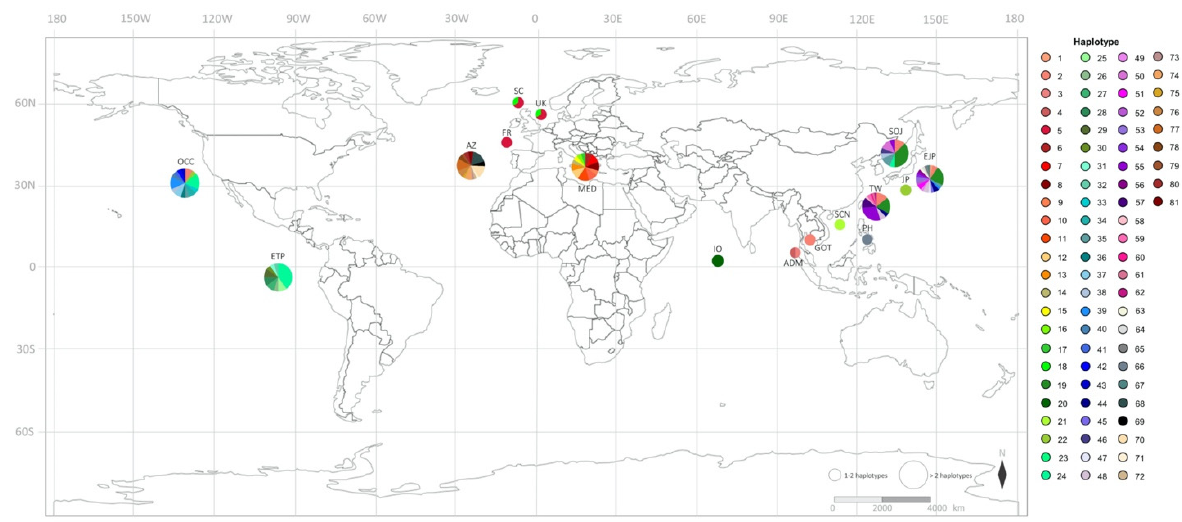
Figure 1. Map showing the geographic distribution of Risso’s dolphin mtDNA control region haplotypes. Each circle represents the haplotypes of Risso’s dolphins in each location. The two sizes of circles indicate the number of haplotypes: smaller, 1–2 haplotypes; larger, >2 haplotypes. The color indicating the haplotype and the proportion of color in each circle are related to haplotype frequency. Abbreviations for location are as follows: AZ, Azores Island; MED, Mediterranean; FR, France; SC, Scotland; UK, United Kingdom; IO, Indian Ocean; ADM, Thai Andaman Sea; GOT, Gulf of Thailand; PH, Philippines; TW, Taiwan; SCN, Southeastern China Sea; SOJ, Sea of Japan; JP, Japan; EJP, Eastern Japan; ETP, Eastern Tropical Pacific Ocean; OCC, Oregon-California Coastal.